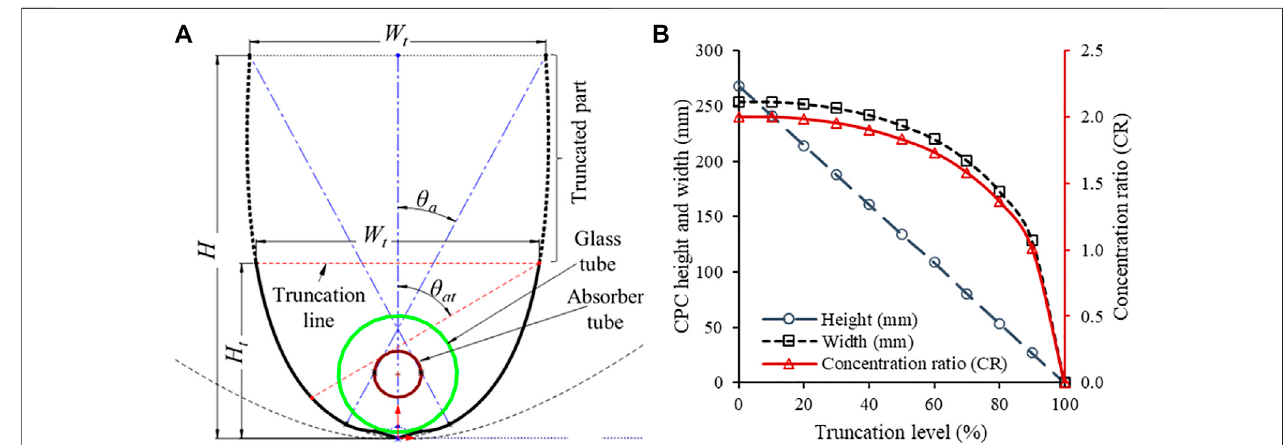
FIGURE 4 | Truncation of the modi fi ed CPC (A) complete pro fi le of the concentrator paired with ETR, (B) effect of truncation on geometric parameters.